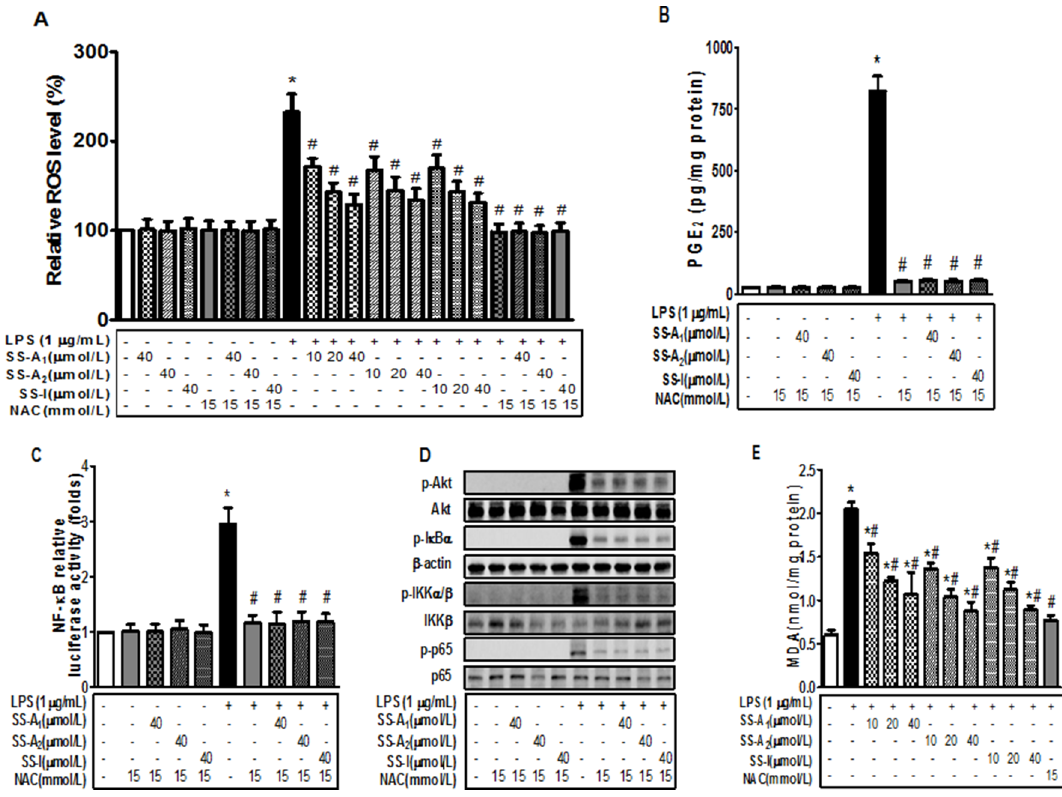
Figure 7. Soyasaponins blunt the LPS-induced ROS production in macrophages. Macrophages were pre-treated with NAC (15 mmol/L) or/ and soyasaponins (A 1 , A 2 or I) for 30 min, and then stimulated with LPS (1 m g/mL) for 16 h as noted. Intracellular ROS level was subsequently quantified by using fluorescent DCF-DA probe and quantified as described in Materials and Methods ( A ). The level of PGE 2 in the media was determined by using an enzyme immunoassay ( B ). ( C ) The pNF-kB-Luc reporter plasmid was introduced into macrophages via transient transfection for overnight, and then stimulated for 16 h with 1 m g/mL LPS in the presence of NAC or NAC plus 40 m mol/L of SS (A 1 , A 2 or I) as noted. The level of luciferase activity was determined and presented as the fold of the negative control. ( D ) Macrophages were pre-treated with NAC alone or NAC plus 40 m mol/L of SS (A 1 , A 2 or I) for 2 h, and then stimulated with LPS (1 m g/mL) for 10 min (for detection of p-IkB a and b -actin), 15 min (for detection of p-IKK a / b , IKK b , p-p65 and p65) or 30 min (for detection of p-Akt and Akt) as noted. Protein levels were detected by using immunoblotting. b -actin was used as a loading control. ( E ) Macrophages were pre-treated with NAC (15 mmol/L) or soyasaponin (A 1 , A 2 or I) for 30 min, and then stimulated with LPS (1 m g/mL) for 16 h as noted, followed by measurements of MDA in the whole cell lysates. Results are presented as means 6 SD of 3